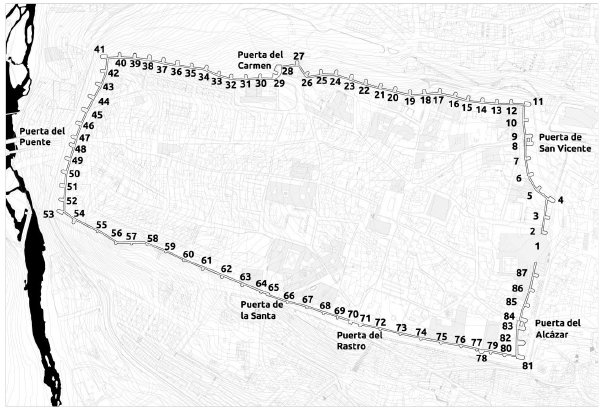
Figure 2. General plan of the walls of Avila. Numbering system of towers and sectors used for the research.